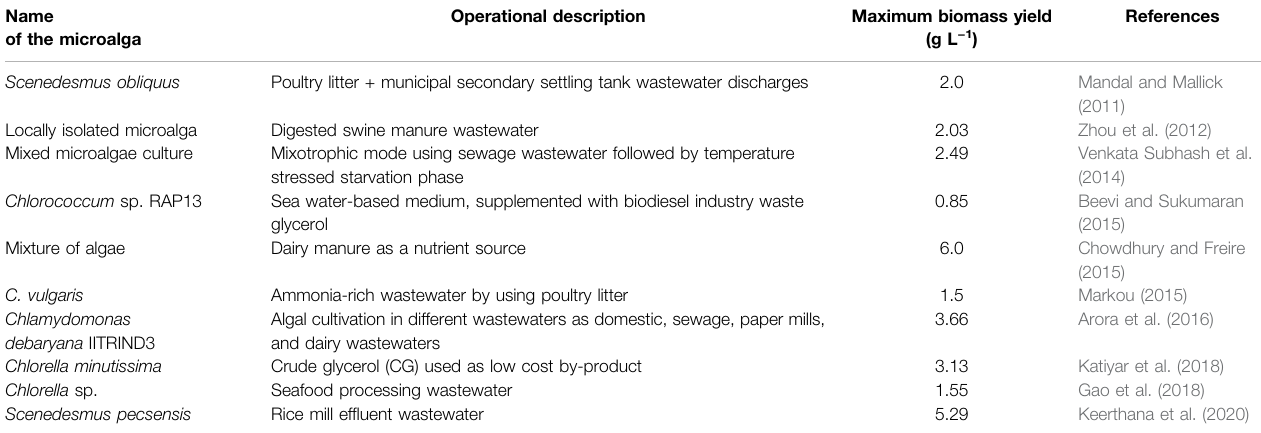
TABLE 1 | Tabulations of various reports on elevated biomass yield by using cost-effective cultivations as the utilization of waste disposal and